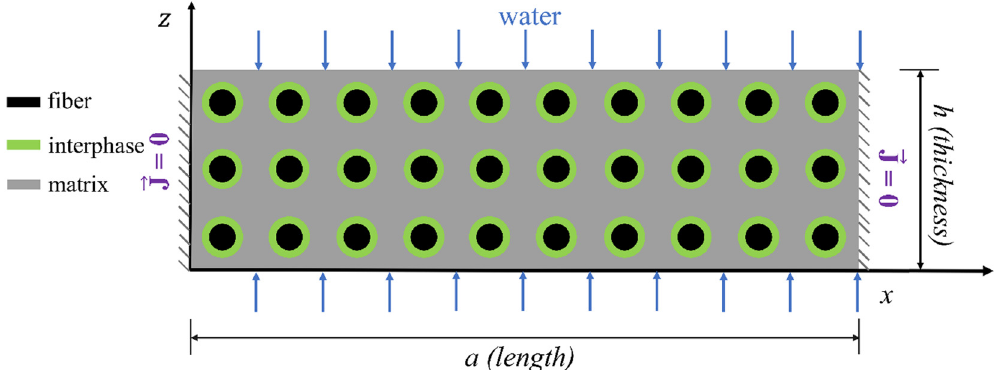
Figure 2: Modeling of water di ff usion in unidirectional